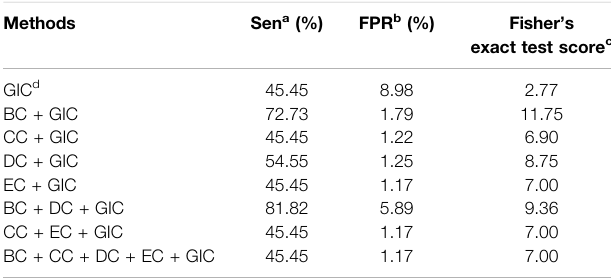
TABLE 2 | Performance analysis on mouse homologs to human essential lncRNAs. Methods Sen a